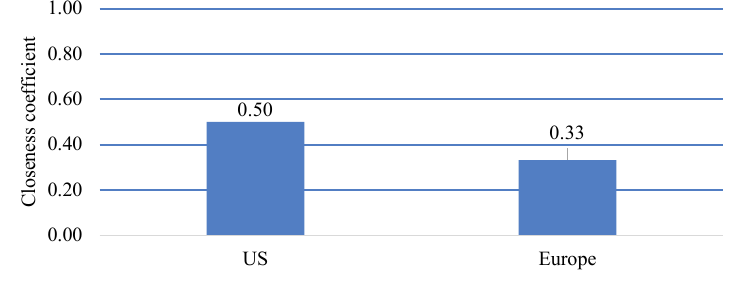
Fig. 5. Results of the TOPSIS analysis at different criteria weights according to the European approach.